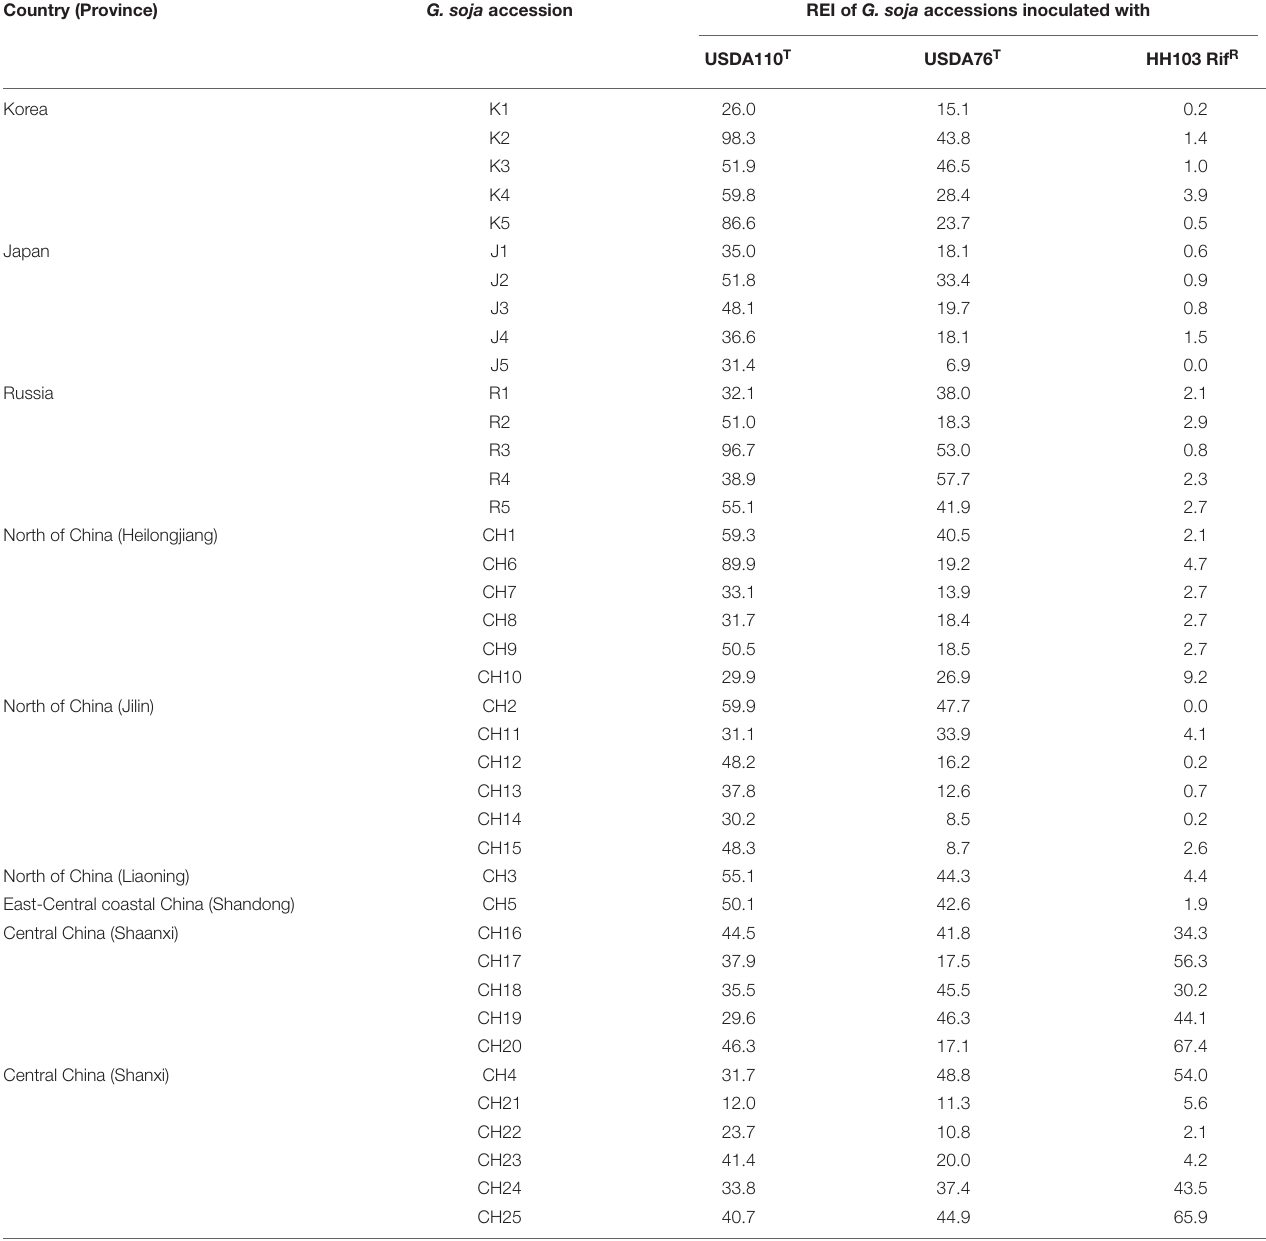
TABLE 2 | Relative Efficiency Indexes (REI) of Glycine soja accessions from Korea, Japan, Russia, and China when grown in combination with B. diazoefficiens USDA110 T , B. elkanii USDA76 T or S. fredii HH103 Rif R . Country